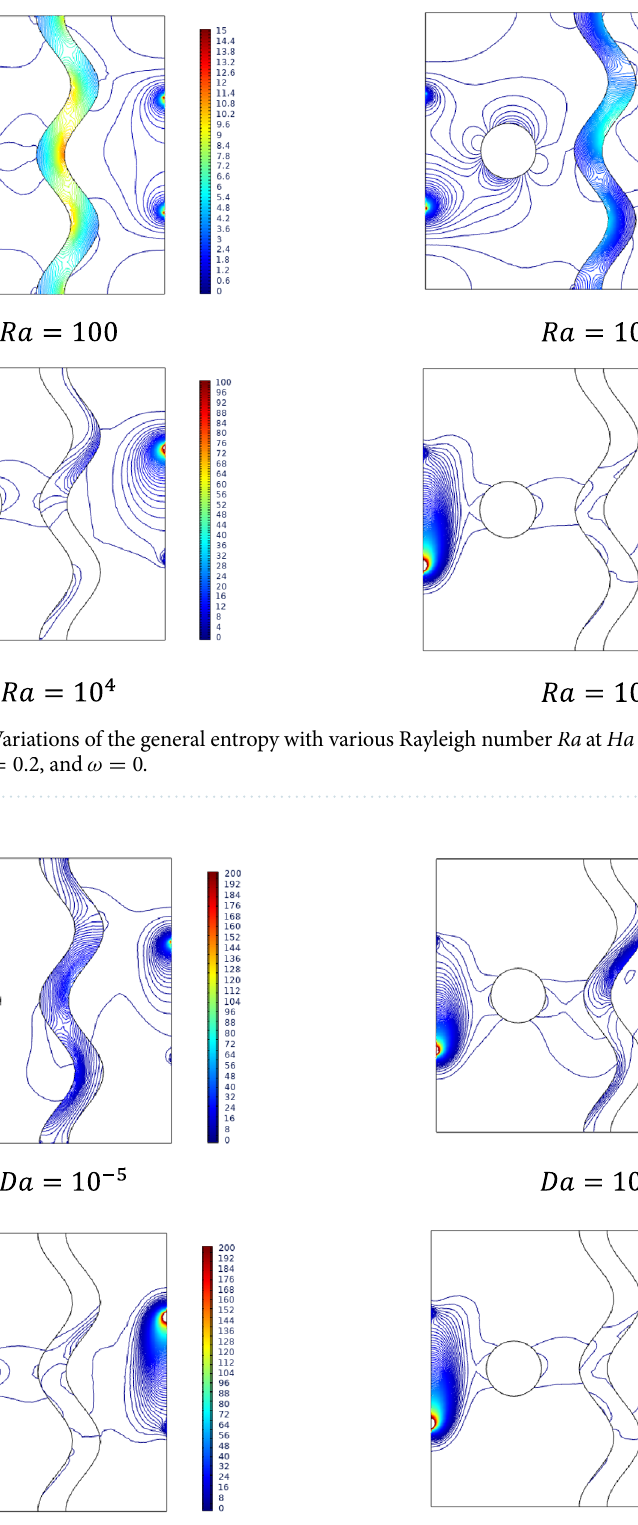
Figure 18. Variations of the general entropy with various Darcy number Da at Ra 0.2 and ω 0.02 , ε φ = =